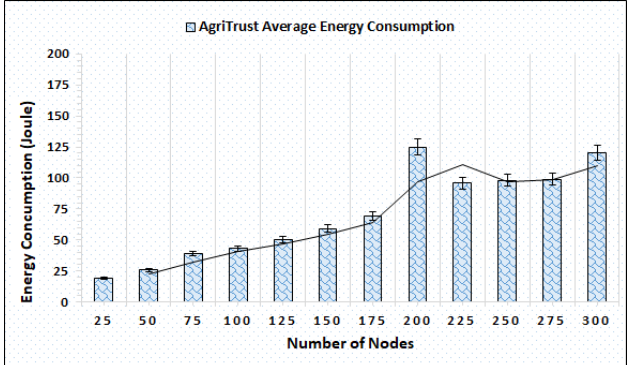
Figure 14. Energy consumption of AgriTrust w.r.t.